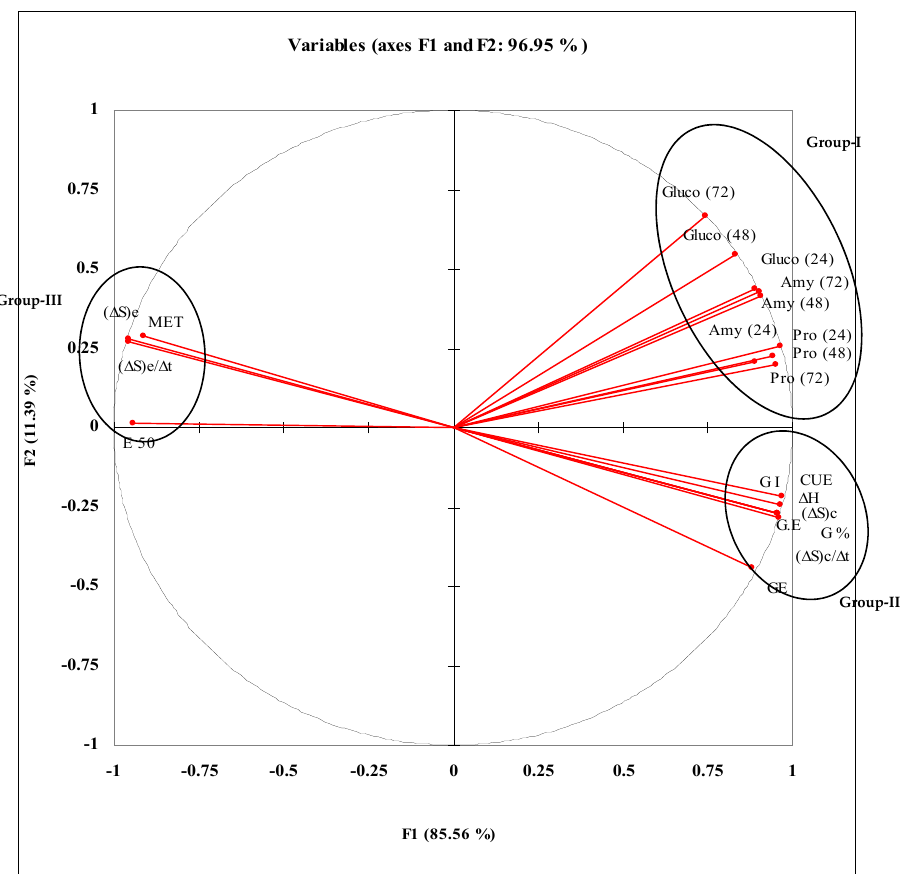
Figure 5. PCA of seed germination attributes of germinating enzymes of laser treated safflower seeds. List of abbreviations ∆ H = enthalpy change; ( ∆ S ) c = entropy generation; ( ∆ S ) c / ∆ t = entropy generation ratio; ( ∆ S ) e = entropy flux; ( ∆ S ) e / ∆ t = en- tropy flux ratio; GE = germination energy; G % = germination percentage; G I = germination index; MET = mean emergence time; E 50 = time to 50% seed germination; Amy (24) = activity of α -amylase after 24 h of seed sowing; Amyl (48) = activity of α -amylase after 48 h of seed sowing; Amy (72) = activity of α -amylase after 72 h of seed sowing; Pro (24) = activity of protease after 24 h of seed sowing; Pro (48) = activity of protease after 48 h of seed sowing; Pro (72) = activity of protease after 72 h of seed sowing; Gluco (24) = activity of glucosidase after 24 h of seed sowing; Gluco (48) = activity of glucosidase after 48 h of seed sowing; Gluco (72) = activity of glucosidase after 72 h of seed